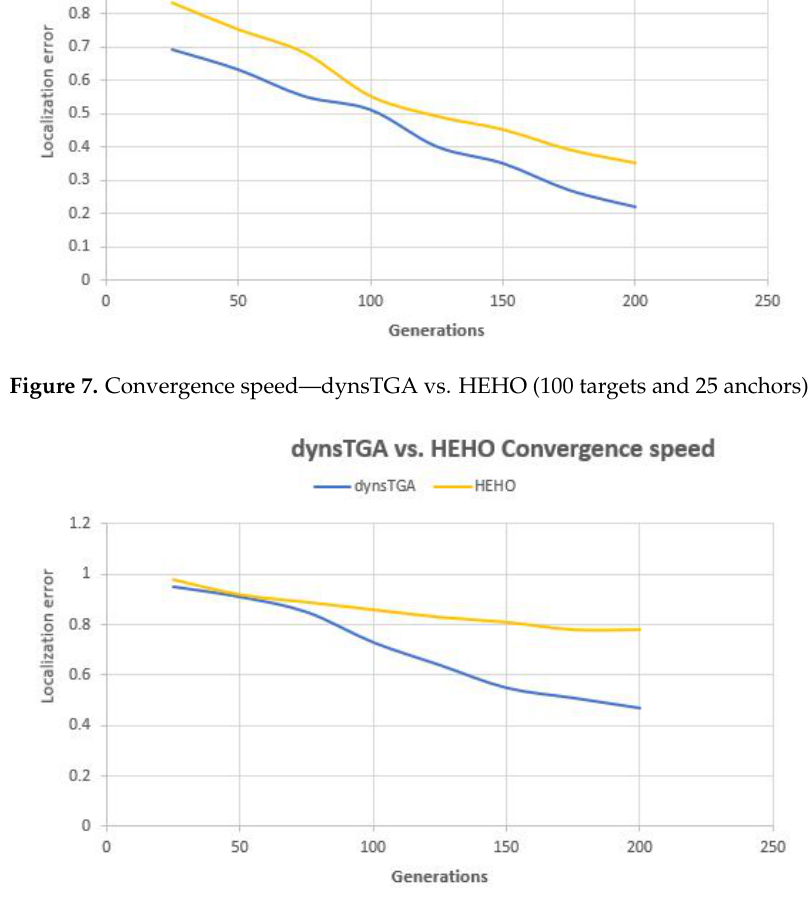
Figure 8. Convergence speed—dynsTGA vs. HEHO (150 targets and 35